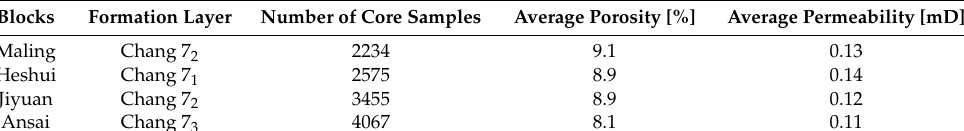
Table 2. The coring details for the analysis of porosity and permeability in Chang 7 reservoir.